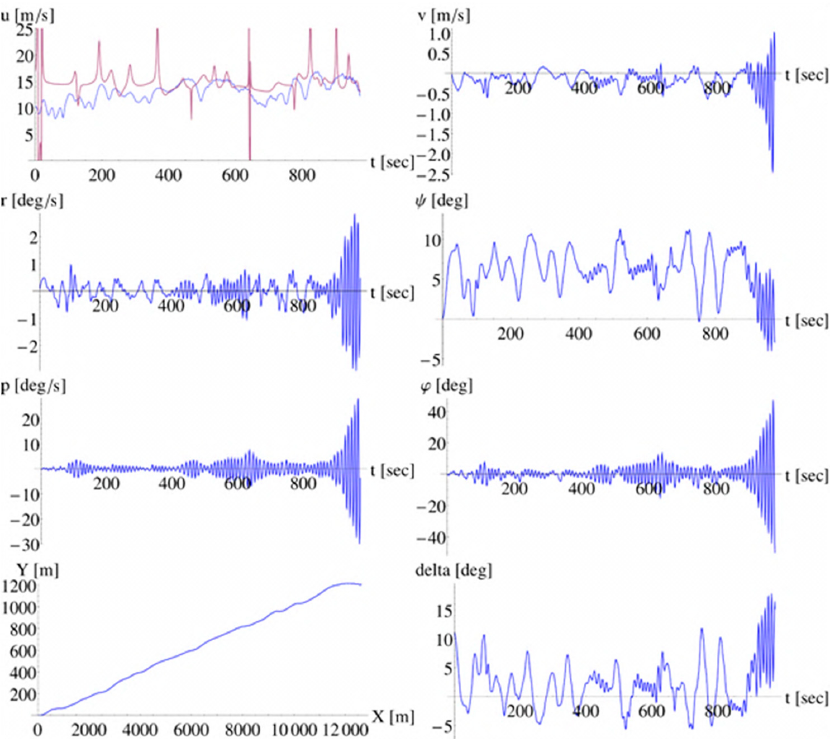
Figure 6. A simulation for the same scenario as in Figure 4, but for a different wave realization and with GM reduced to 2.5 m. Behavior of parametric type, regarding the response in roll, has appeared ( GM = 2.5 m, 𝜓 (cid:2928) = 7.5 (cid:2925) ).